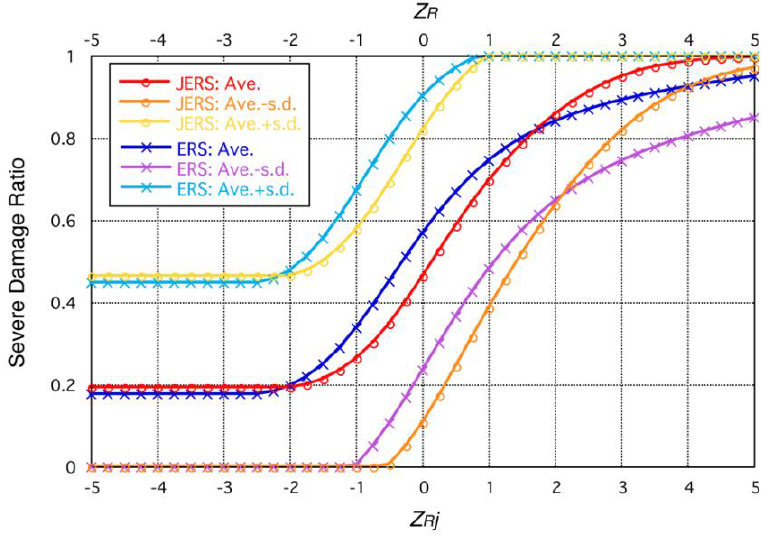
Figure 6. Relationship between the discriminant scores Z severe damage ratio (average values and standard deviations).